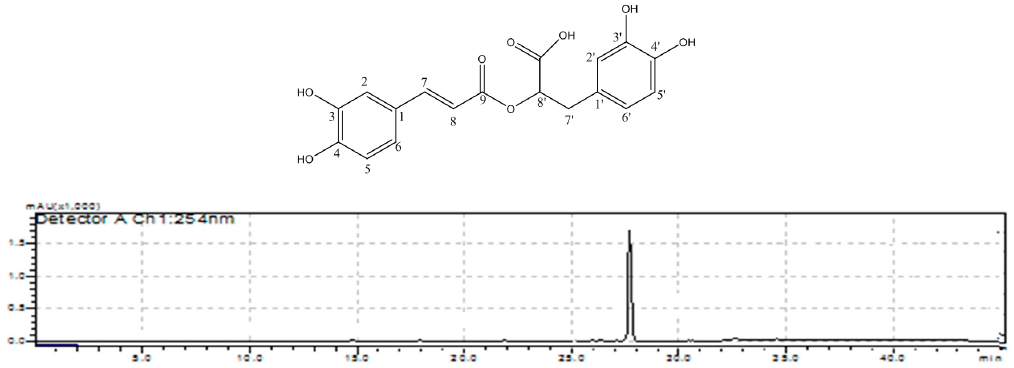
Figure 5. HPLC-UV-VIS analysis of F 2 containing pure compound 1 (rosmarinic acid) ( λ = 340 nm, Poreshell 120 SB-C 18 column).